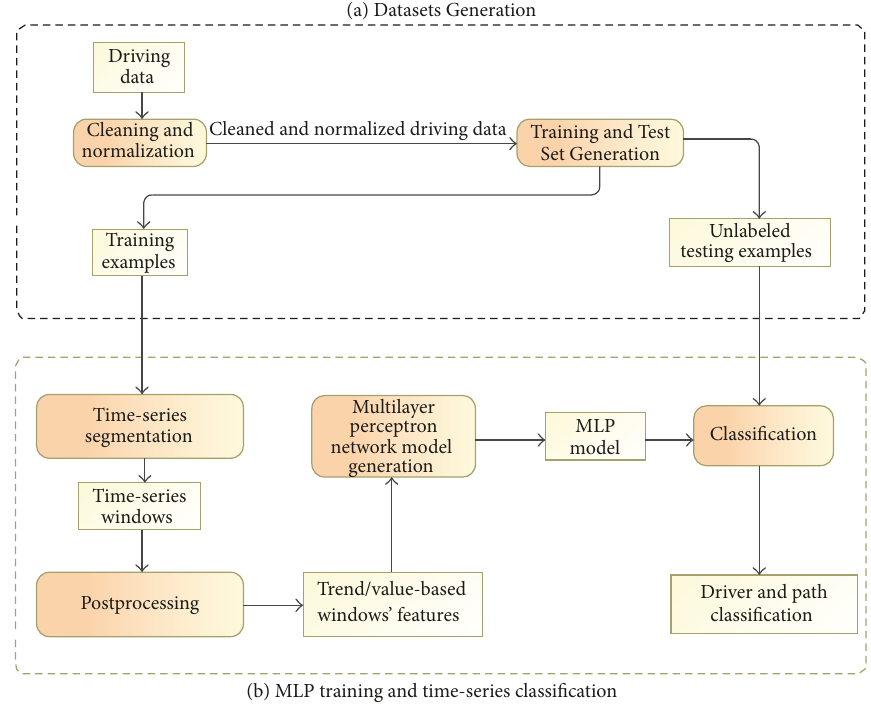
Figure 1: The overall classification